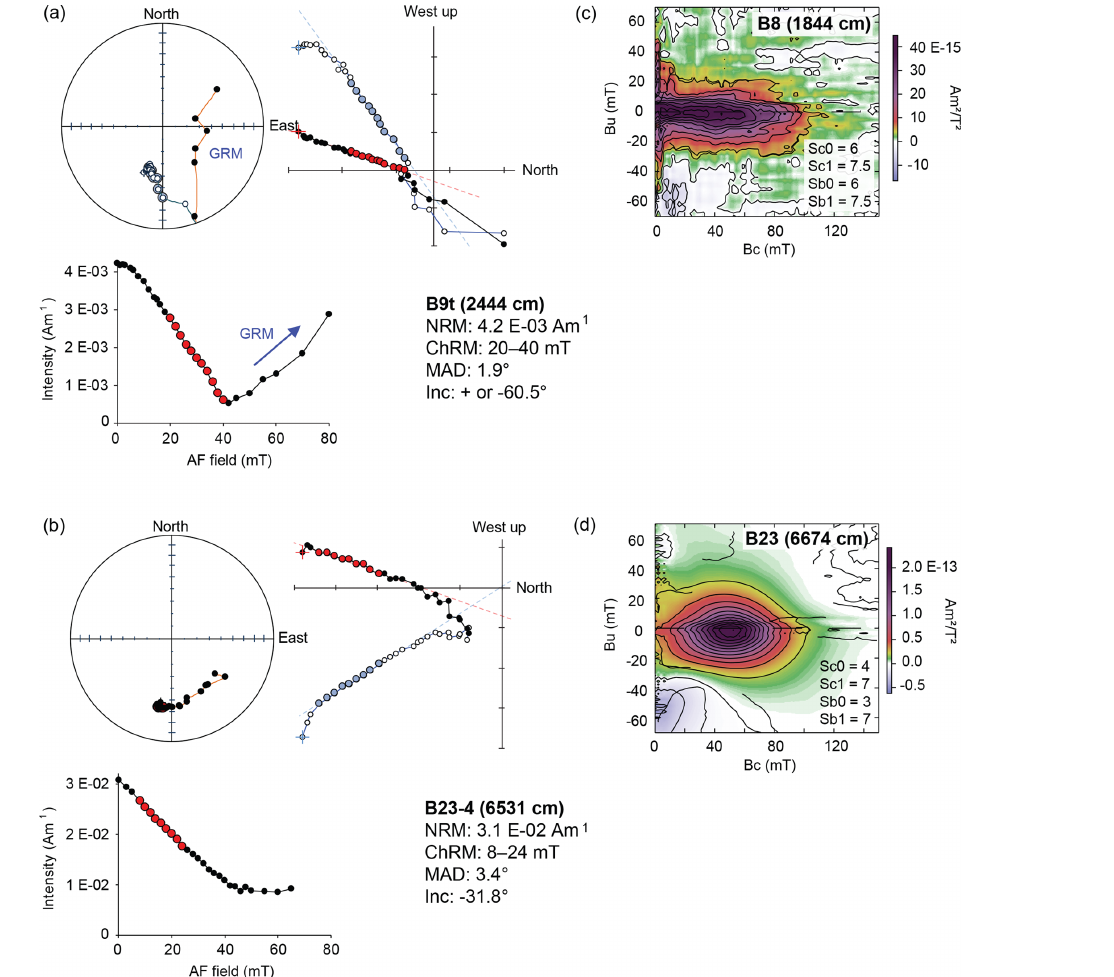
Figure 6. Selected paleo- and rock-magnetic results. Orthogonal projections and alternating field demagnetisation plot for (a) lake sediment sample B9t, and (b) oriented pre-lake sediment sample B23-4 displaying normal polarity. The down-core position of the samples are indicated by an asterisk in Fig. 5. The acquisition of gyroremanence (GRM) in AF >40mT is typical of greigite (Roberts et al., 2011). A hard coercivity component is present in sample B23-4, where about one third of the NRM remains after AF 65mT. First-order reversal curve (FORC) diagrams for samples (c) B8 and (d) B23. The closed peak distribution indicates single domain (SD) magnetic particles (Roberts et al., 2014), which are stable remanence